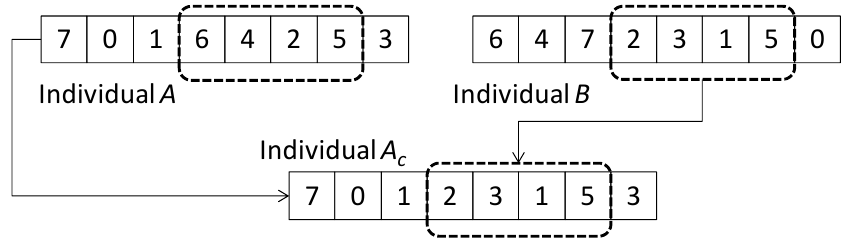
Figure 3. An example of the crossover operation.